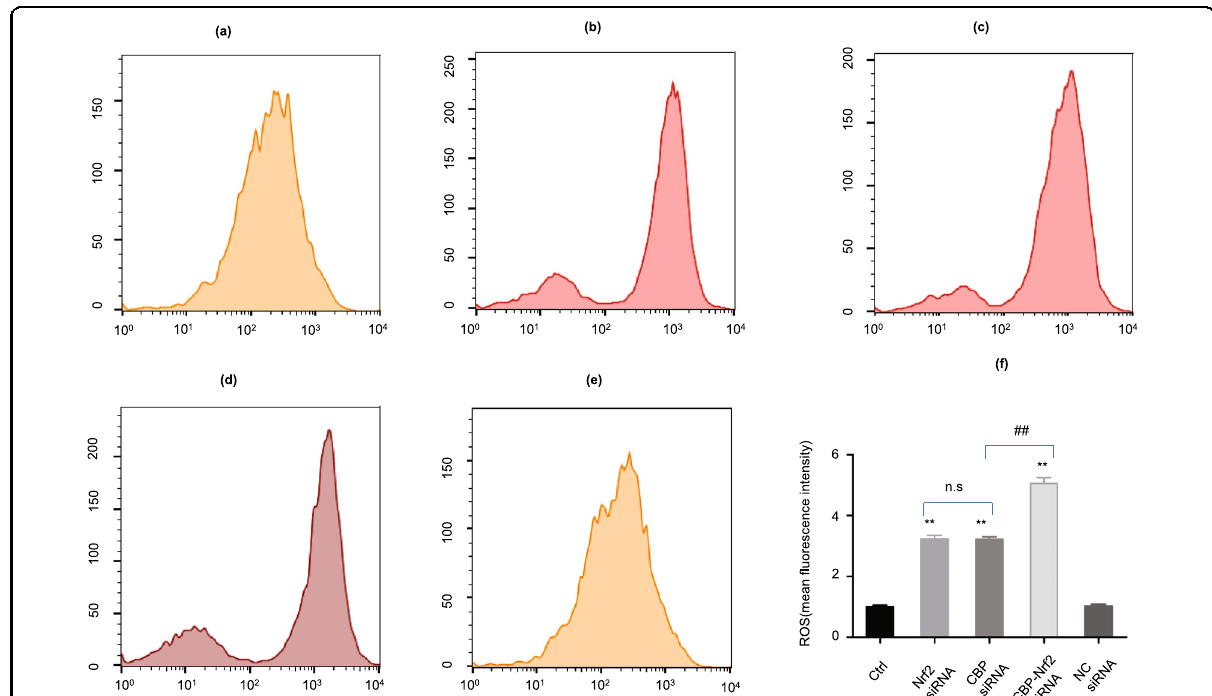
Fig. 3 Effects of co-transfection of CBP siRNA and Nrf2 siRNA on the ROS accumulation in A375 cells. a Control group; b Nrf2 siRNA(70% depletion); c CBP siRNA(70% depletion); d co-transfections of CBP siRNA and Nrf2 siRNA (the dose of siRNA applied equals to 70% depletion of CBP and Nrf2, respectively); e NC siRNA group; f measurements of the ROS by the DCF fl uorescence intensity. Data as shown in the fi gures were expressed as mean ± SEM ( n = 3). * P < 0.05, ** P < 0.01, # P < 0.05, ## P < 0.01, and n.s denotes P >